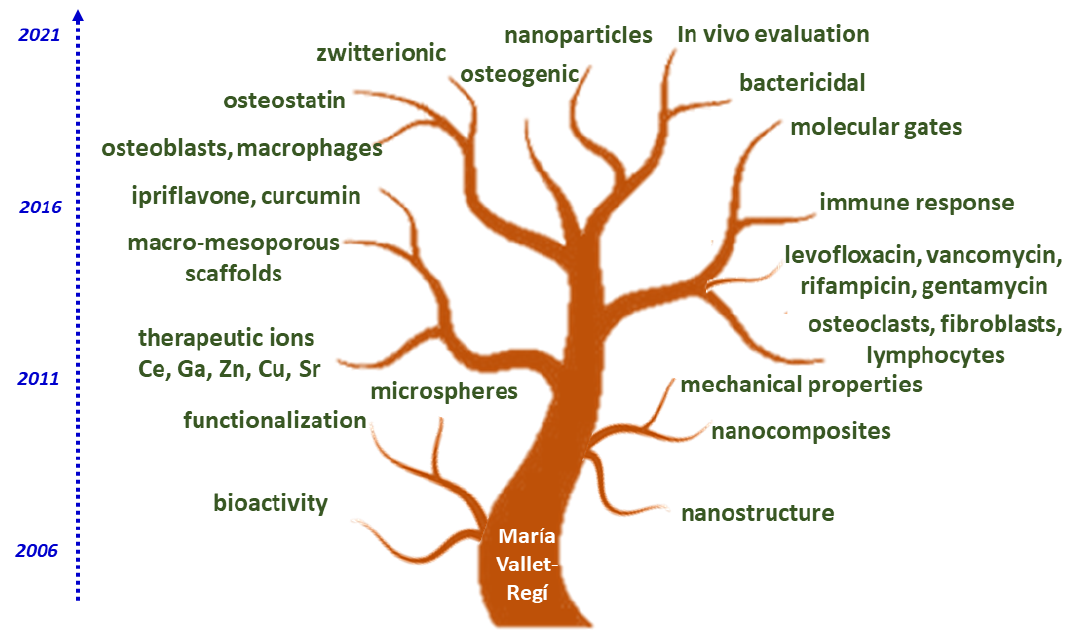
Figure 5. MBGs tree after María Vallet-Regí.